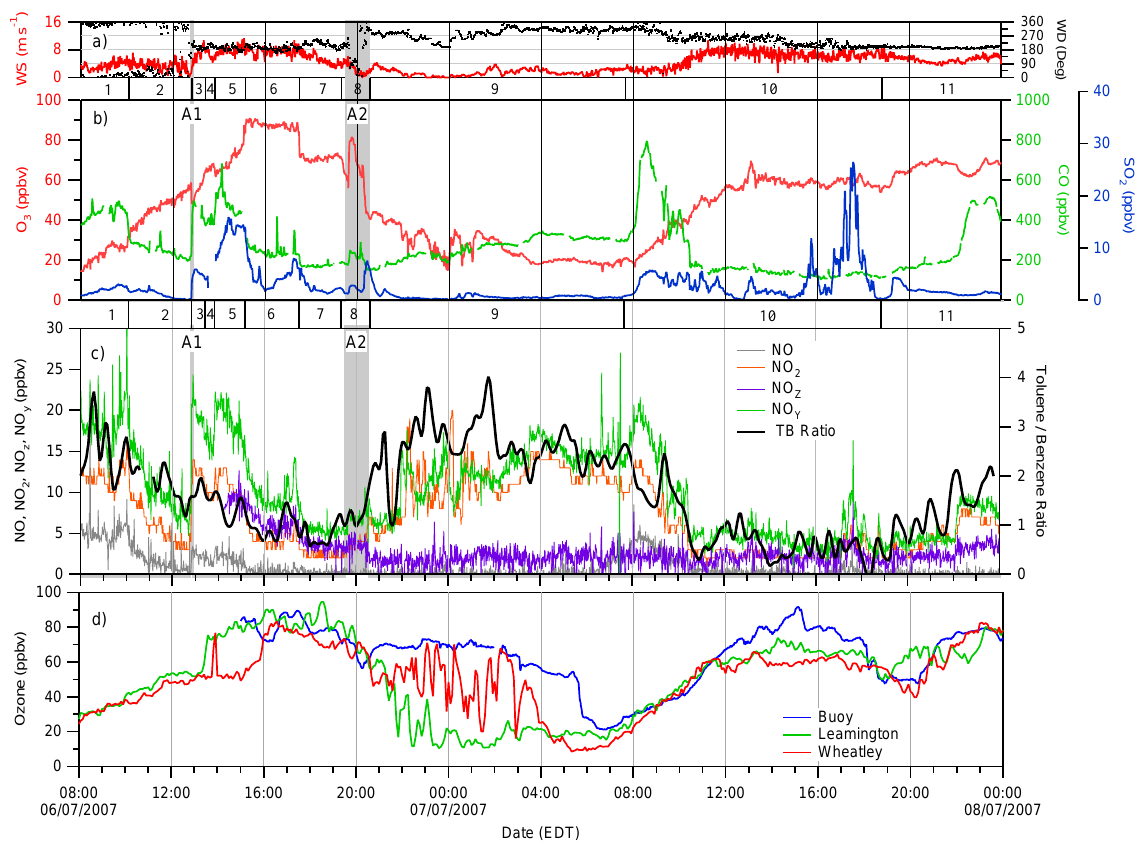
Fig. 6. Measurements from 6–7 July including: (a) wind speed and direction at Harrow; (b) O 3 , CO and SO 2 mixing ratios at Harrow; (c) NO, NO 2 , NO z and NO y , as well as toluene-to-benzene ratio (TBR) at Harrow; and (d) O 3 at three additional sites (Wheatley, Leamington, and the Lake Erie buoy). Thick gray vertical lines mark the times of the first two lake-breeze frontal passages at Harrow, marked A1 and A2. Numbering (1–11) refers to the different stages detailed in the